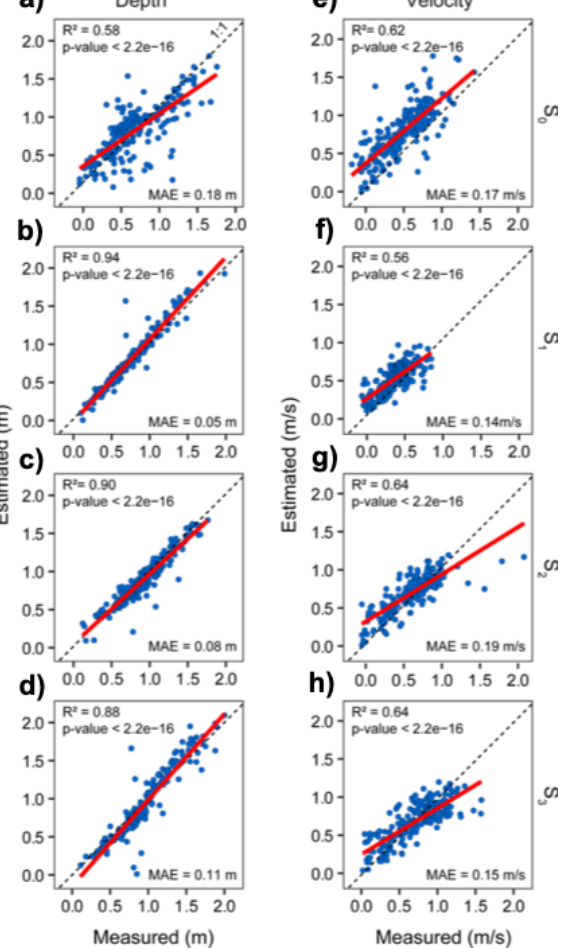
Figure 6. Estimated versus measured depths ( a – d ) and velocities ( e – h ) for each state. S 0 , S 1 , S 2 , and S 3 correspond to each monitoring